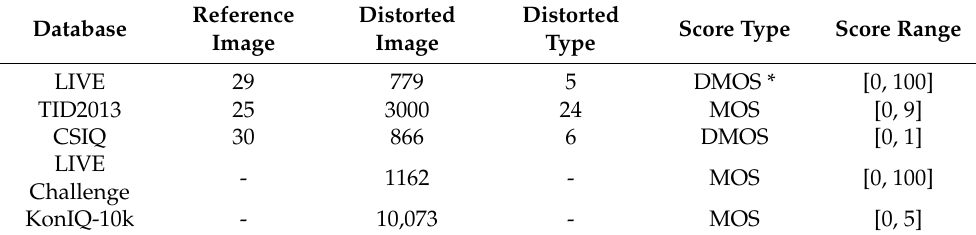
Table 1. IQA datasets for performance evaluation and model training.